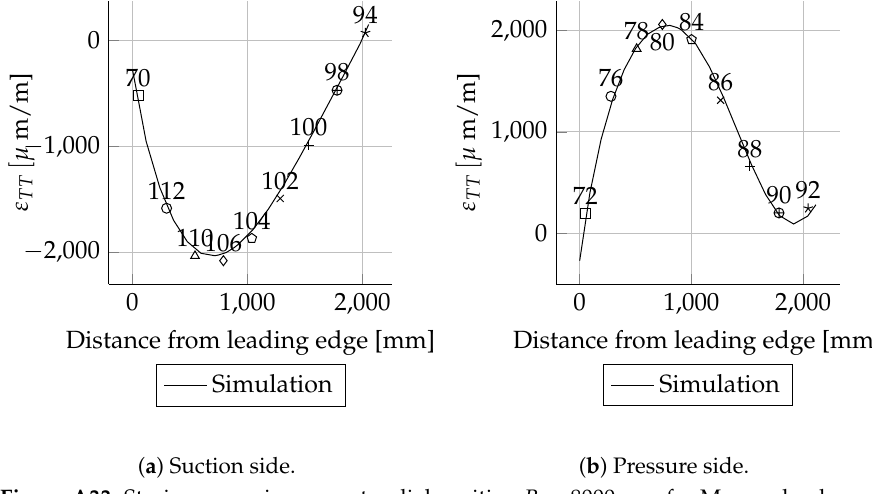
Figure A33. Strain comparison ε LL at radial position R = 8000 mm for Mymax load case.